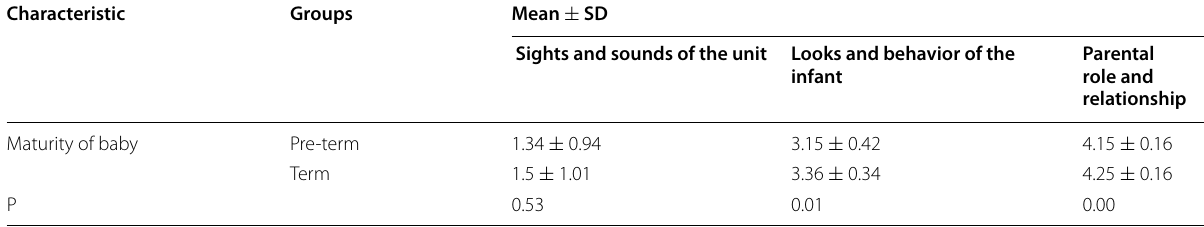
Table 4 Mean Stress Scores of each domain of PSS: NICU scale in relation to the maturity of the baby Characteristic